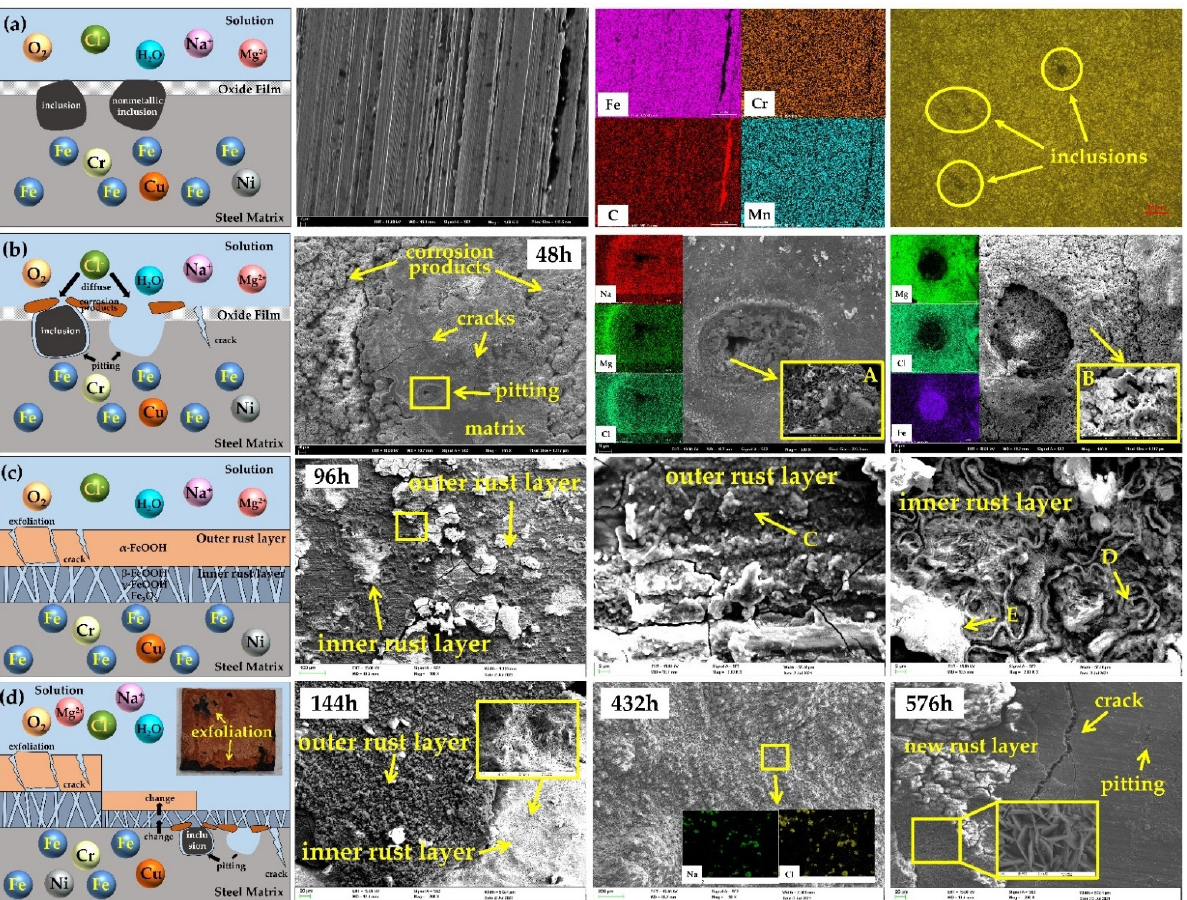
Figure 3. Corrosion behavior diagram with SEM and EDS analysis: ( a ) blank; ( b ) pitting; ( c ) exfoli ‐ ation; ( d ) corrosion cycle. tion; ( d ) corrosion